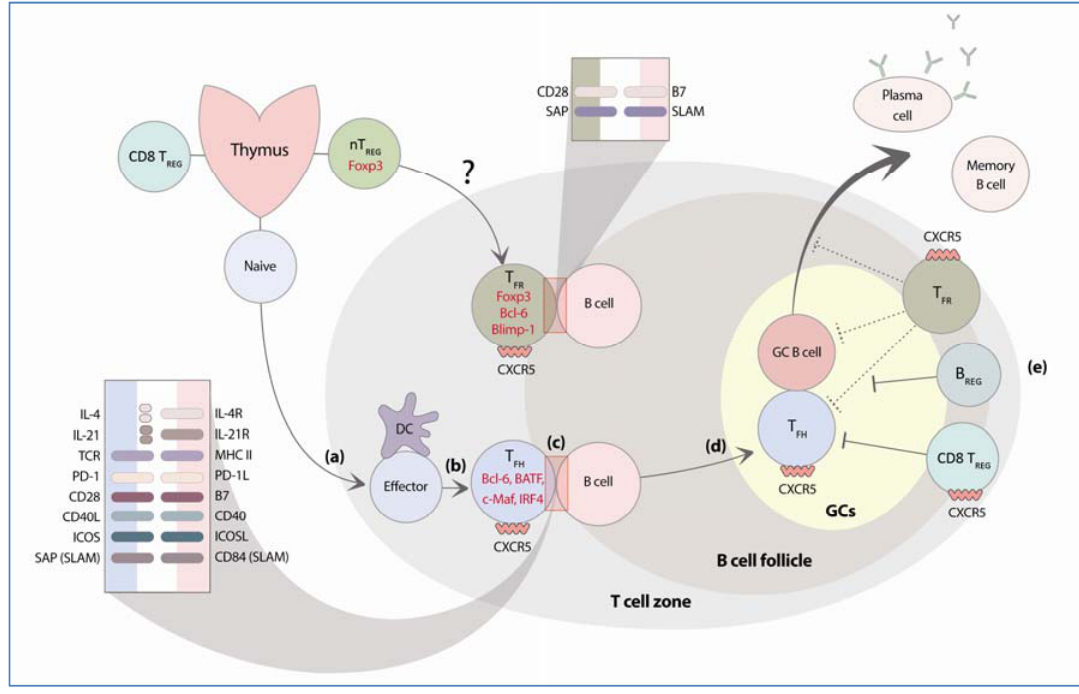
Figure 1. Schematic view of germinal center reactions. ( a ) Naïve CD4 + T cells interact with antigen-presenting dendritic cells (DCs) in the T cell zones. ( b ) Activated T cells transiently express CXCR5 and migrate to the T-B border. ( c ) Interaction of CXCR5 + T cells with Ag-specific B cells and follicular DCs further promote T differentiation, as FH cells induce clone well as the formation of germinal center (GC). ( d ) In GC, T FH expansion, somatic hypermutation, and class switching of B cells. ( e ) The interaction of T and B cells leads to the generation of memory B cells and long-lived antibody- FH cells producing plasma cells. Transcription factors, Bcl-6, c-Maf, BATF and IRF4, in T FH direct the expression of T signature genes, including CXCR5, ICOS, IL21, and PD1. FH Interactions of CD28:CD86, CD40L:CD40, PD-1:PD-1L, SLAM:SAP and ICOS: ICOSL and B cells are required for GC formation. ( f ) Follicular regulatory T cells between T FH (T ), Qa-1 restricted CD8 + regulatory T cells, and IL-10 producing regulatory B (B ) FR REG cells are known to suppress GC